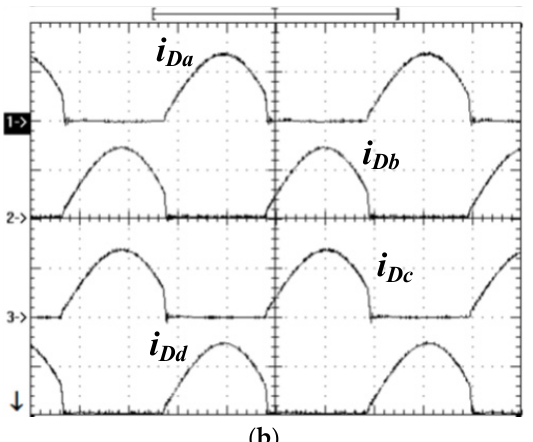
Figure 10. Experimental waveforms of i Da ~ i Dd at 100% rated power under ( a ) 750 V input voltage